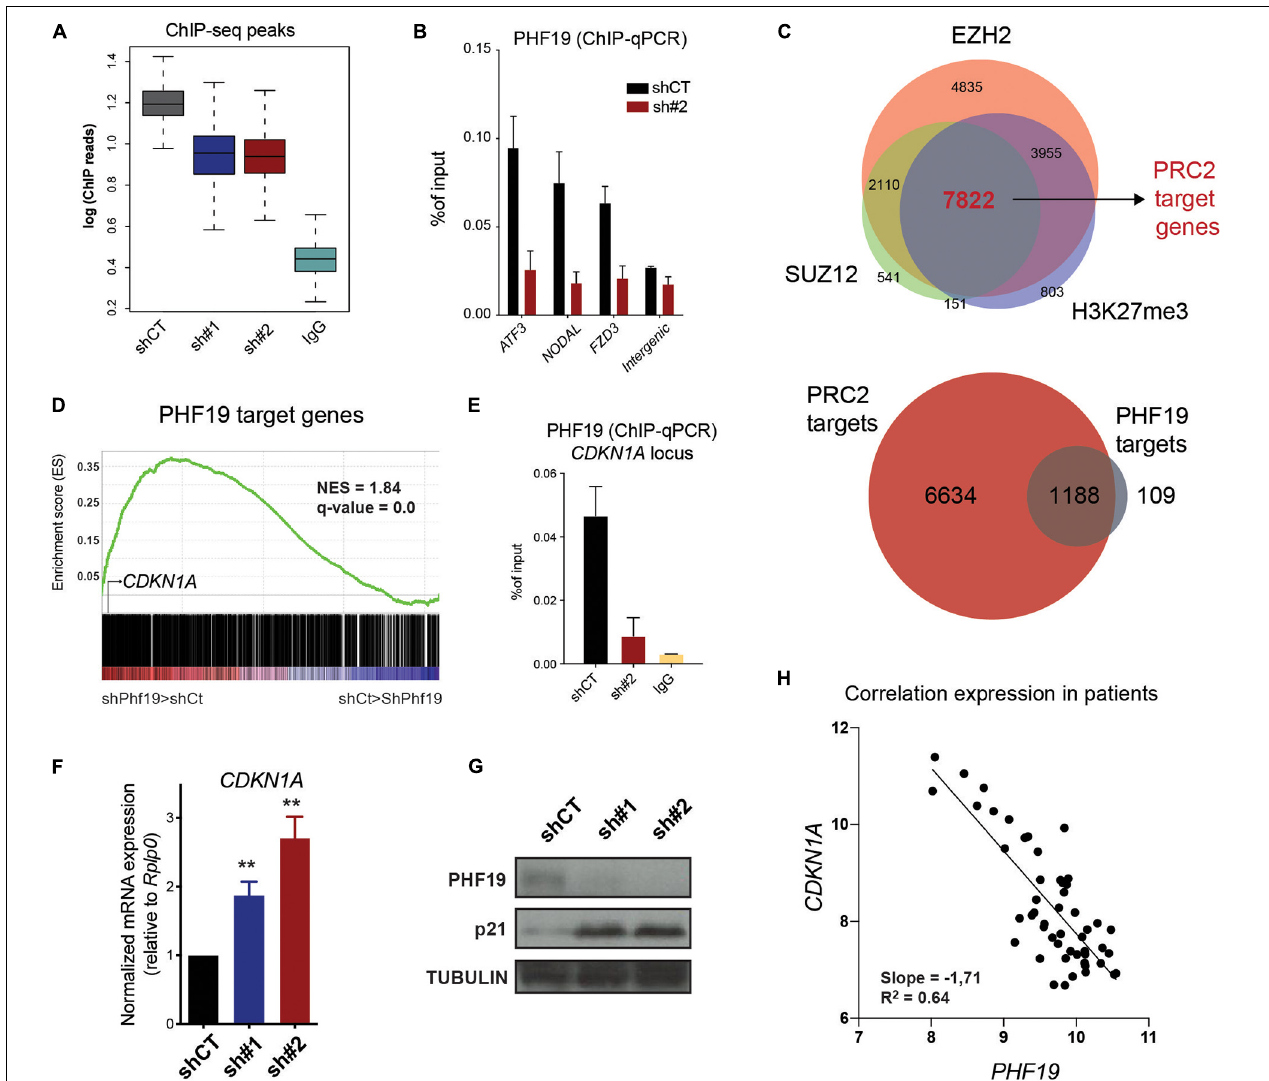
FIGURE 3 | (A) Boxplot of the total number of reads in PHF19 chromatin immunoprecipitation sequencing (ChIP-seq) peaks. (B) PHF19 ChIP enrichment (with respect to the input) measured by qPCR of several genes and intergenic region as a negative control for the cells infected with an empty short hairpin RNA (shRNA, shCT ) and a shRNA against PHF19 (sh#2). Mean ( n > 2) + SEM. (C) Venn diagrams showing the intersection between the EZH2, SUZ12, and H3K27me3 target genes ( top ) and between these common targets and PHF19 target genes ( bottom ). (D) Gene set enrichment analysis (GSEA) showing positive enrichment in